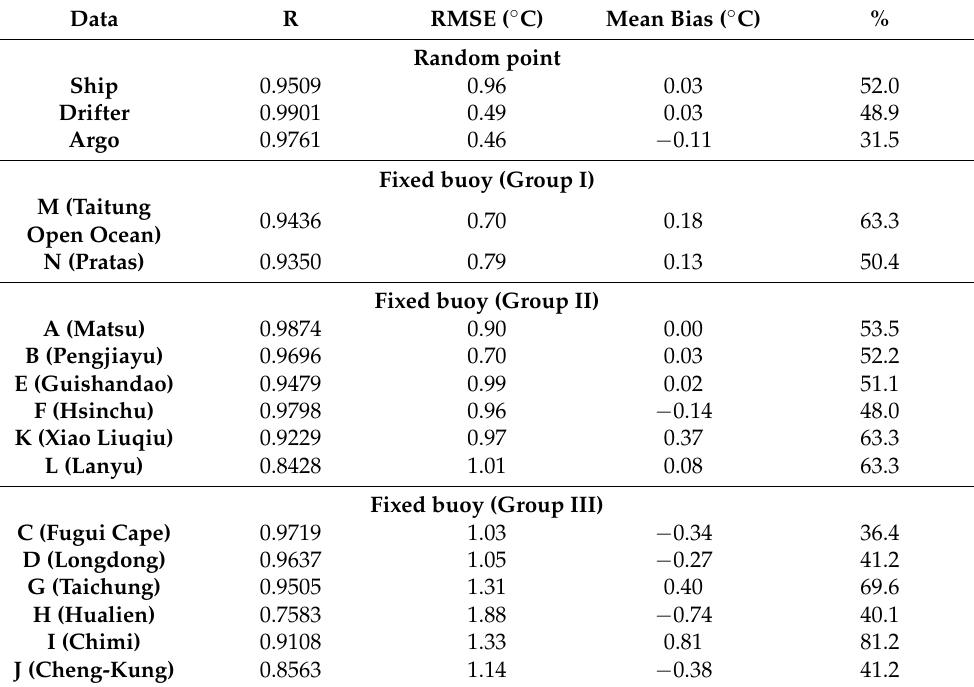
Table 3. Statistical results between bulk SST and skin SST; % represents the proportion of bulk SST higher than skin SST.